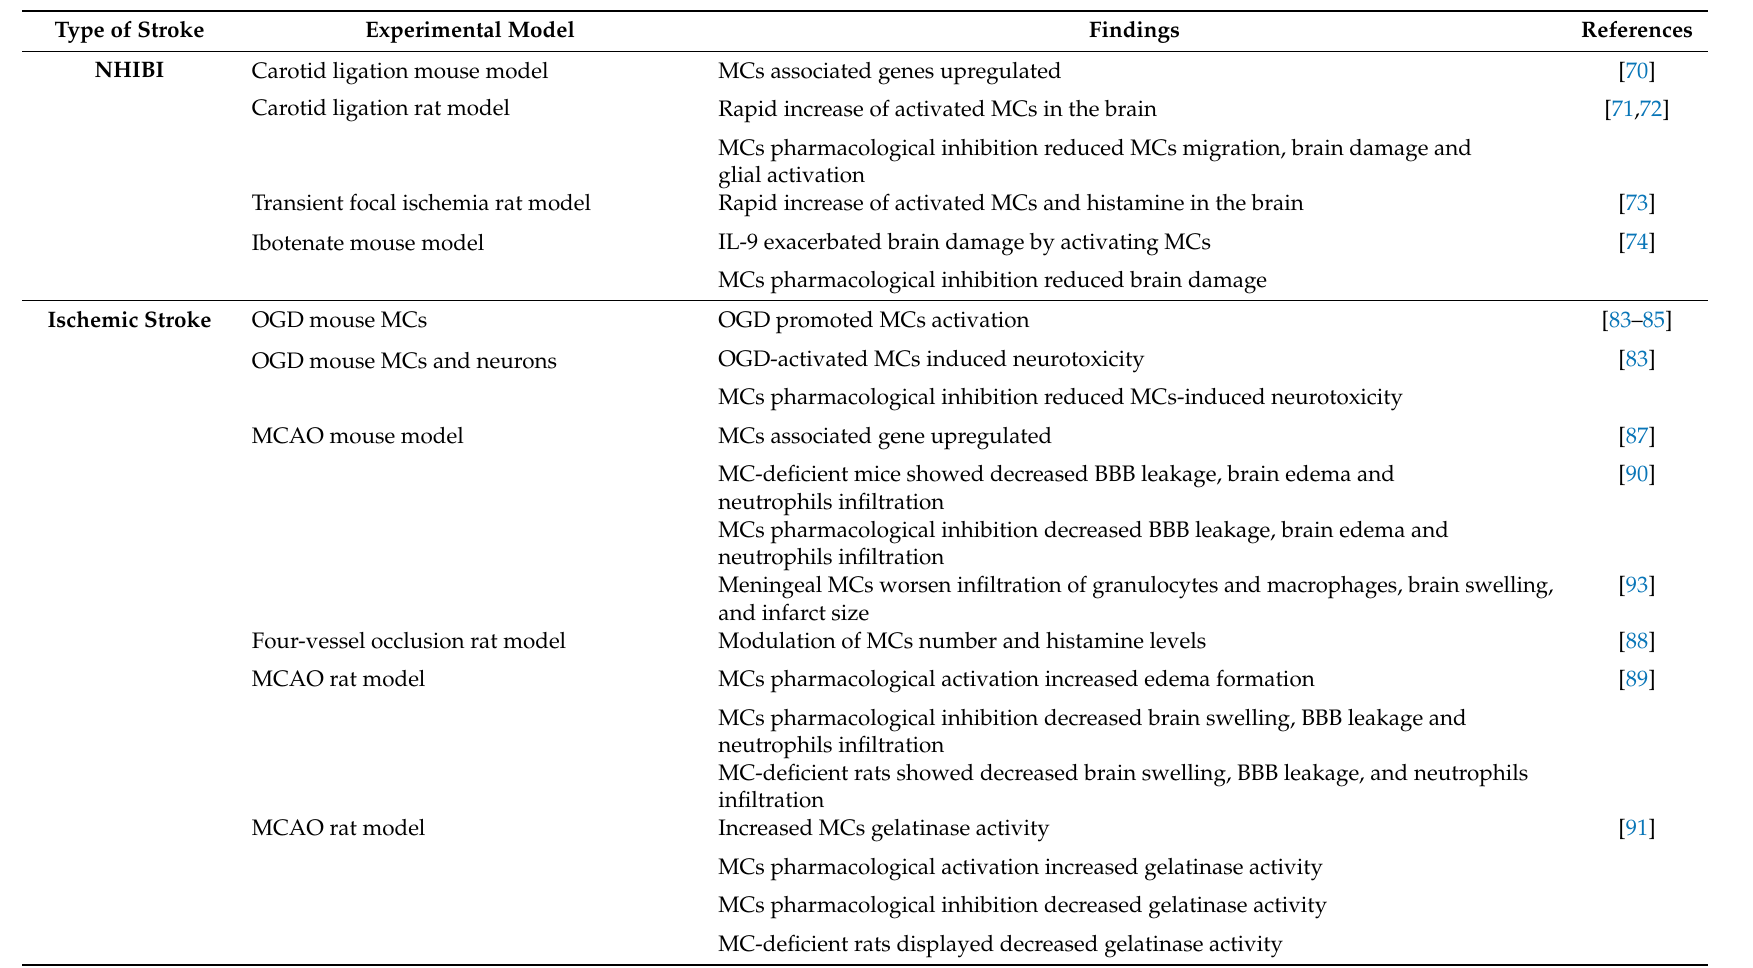
Table 1. Role of mast cells in the pathogenesis of